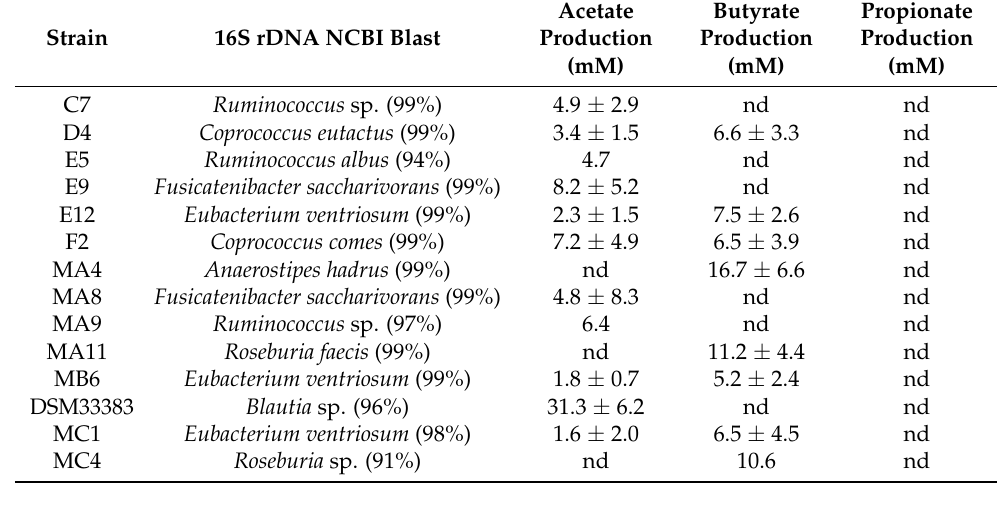
Table 1. Closest homology (%) to the 16S of the 14 selected strains, with the 16S rDNA sequences of the strains in the NCBI database. The homology was based on the partial or full 16S rDNA of strains isolated from a healthy human fecal sample. Short chain fatty acid production in stationary phase after an overnight culture in BHIS(+). Median ± interquartile range, n = 4 except for strains E5, MA9, and MC4, where n =1, nd = not detected (under 0.2 mM).